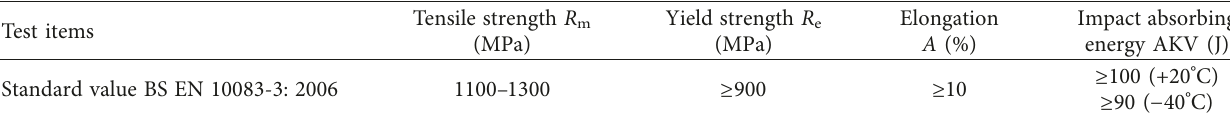
Table 2: Mechanical properties of 34CrNiMo6 steel for wind turbine main shaft.